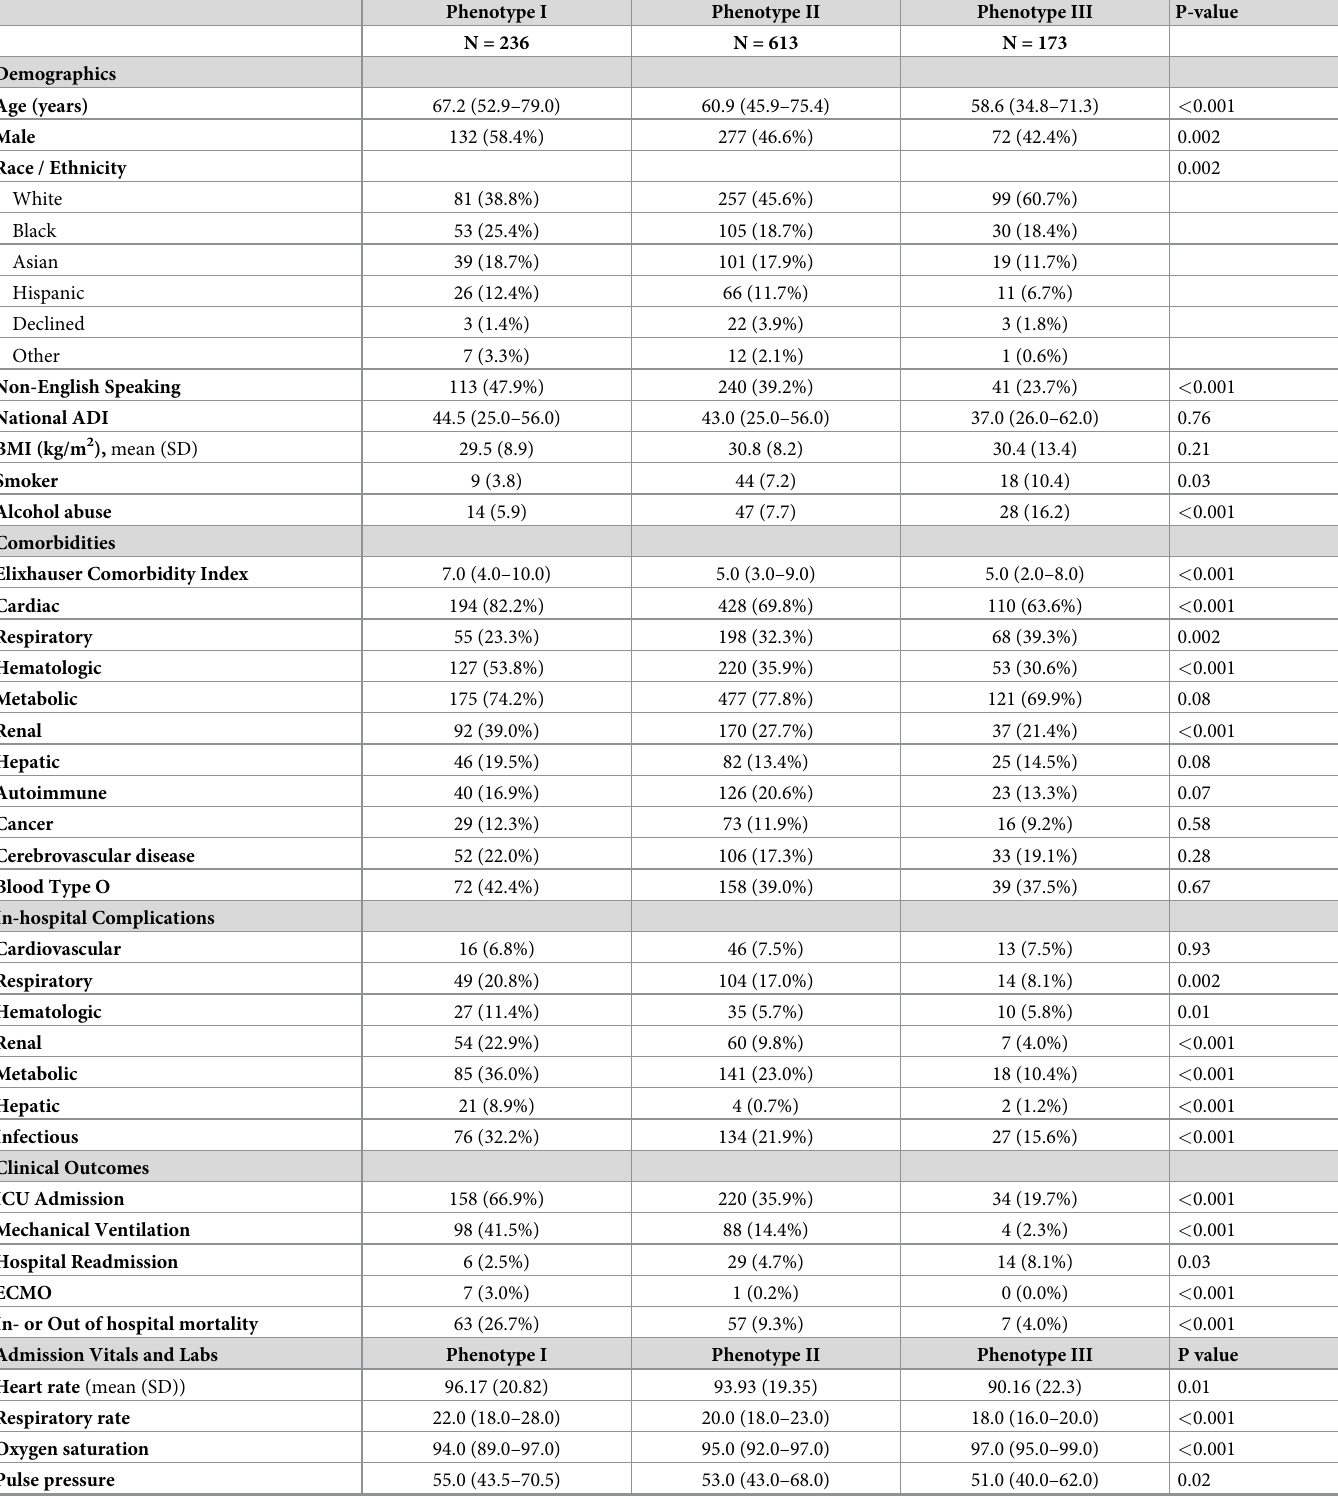
Table 1. Baseline demographics, comorbidities, and clinical outcomes of hospitalized COVID-19 patients with clinical phenotypes I, II, and